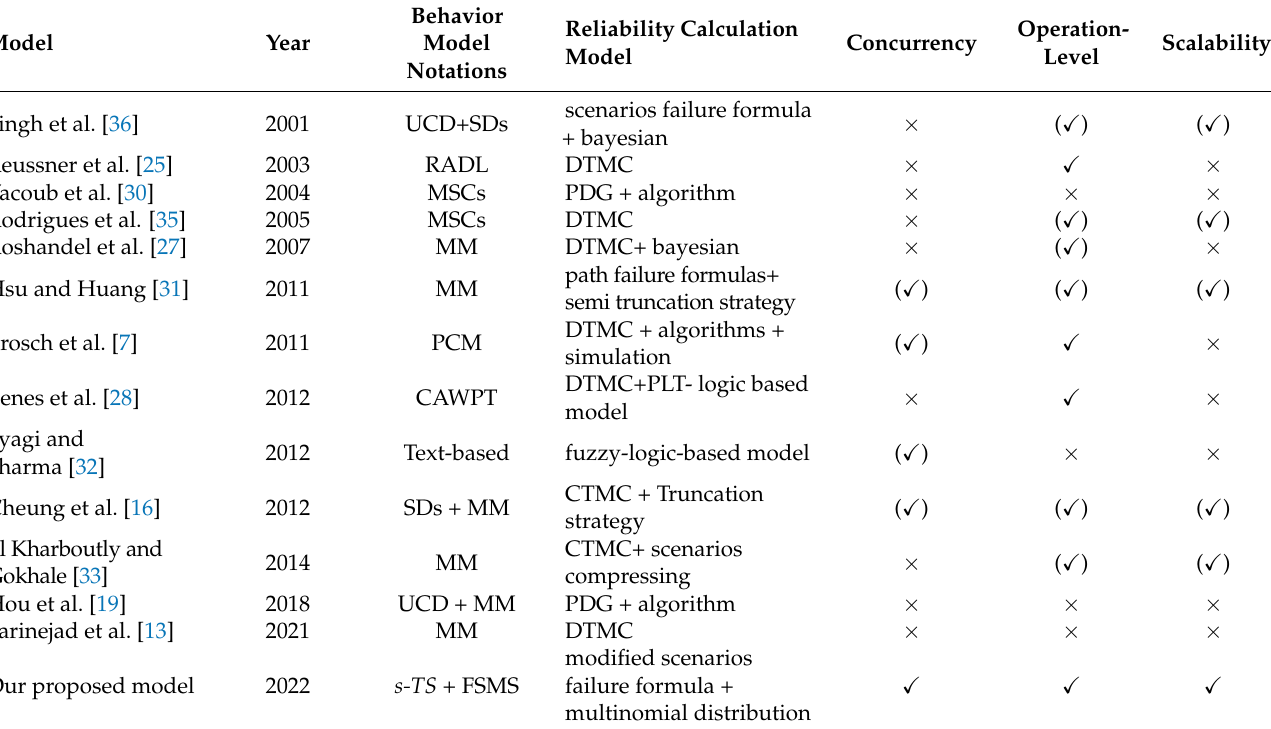
Table 1. Comparison of design-time reliability prediction